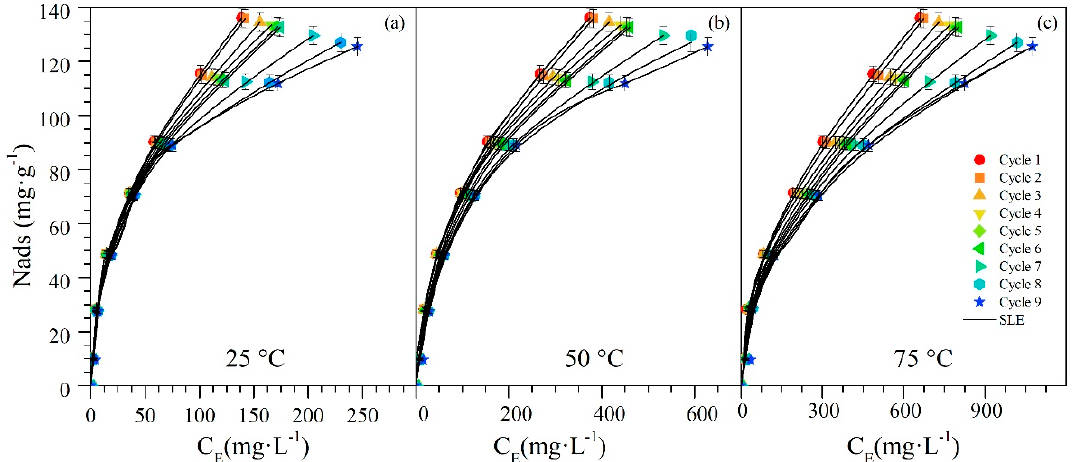
Figure 2. Adsorption isotherms of n -C 7 asphaltenes onto CeNi0.89Pd1.1 nanoparticles evaluated at ( a ) 25°C, ( b ) 55°C, and ( c ) 75°C through catalyst regeneration cycles of adsorption and subsequent catalytic steam gasification. Adsorption isotherms were constructed for different n -C 7 asphaltene concentrations from 100 mg·L − 1 to 1500 mg·L − 1 . The symbols are experimental data, and the solid lines are from the SLE model. Table 2. Estimated values of the solid − liquid equilibrium (SLE model parameters Henry’s law constant ( K H ), the degree of self-association ( K . ) and maximum amount adsorbed ( N max ) for n -C 7 asphaltene adsorption isotherms onto CeNi0.89Pd1.1 nanoparticles, evaluated at 25°C, 55°C, and 75°C through catalyst regeneration of adsorption and subsequent catalytic steam gasification.